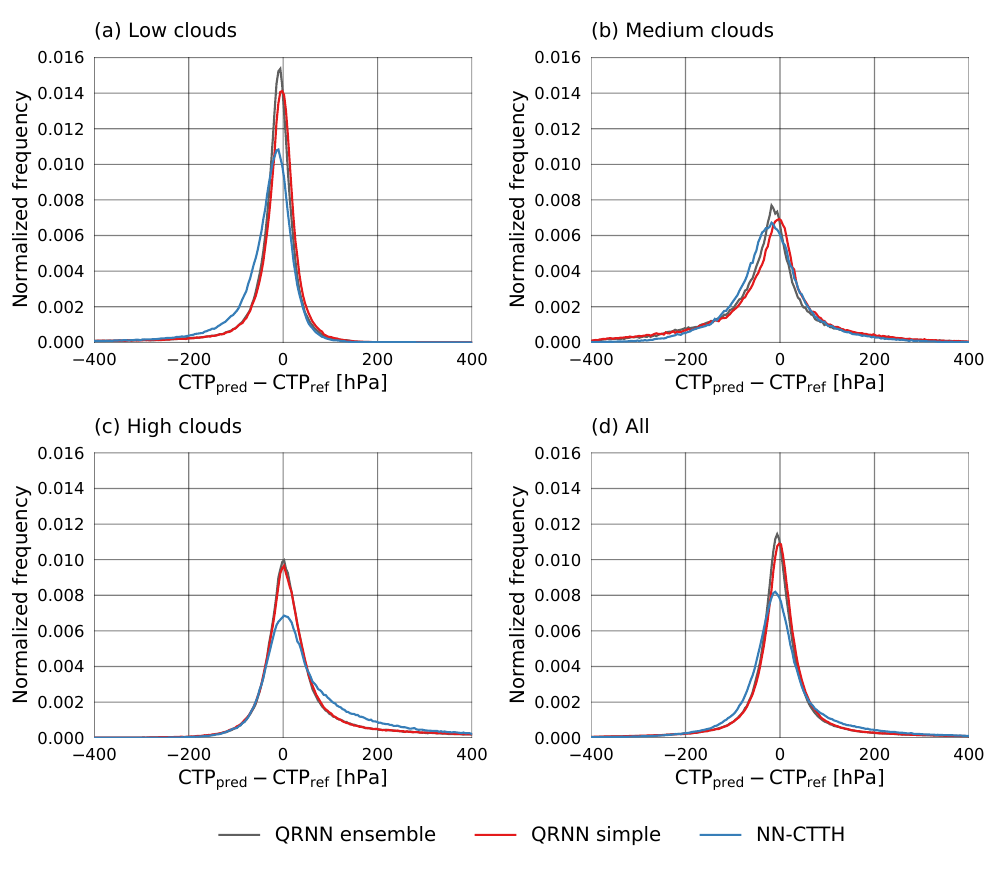
Figure 10. Error distributions of predicted CTP values ( CTP pred ) with respect to CTP from CALIOP (CTP ref ) for high clouds (a) , medium clouds (b) , low clouds (c) and the complete test set (d) .